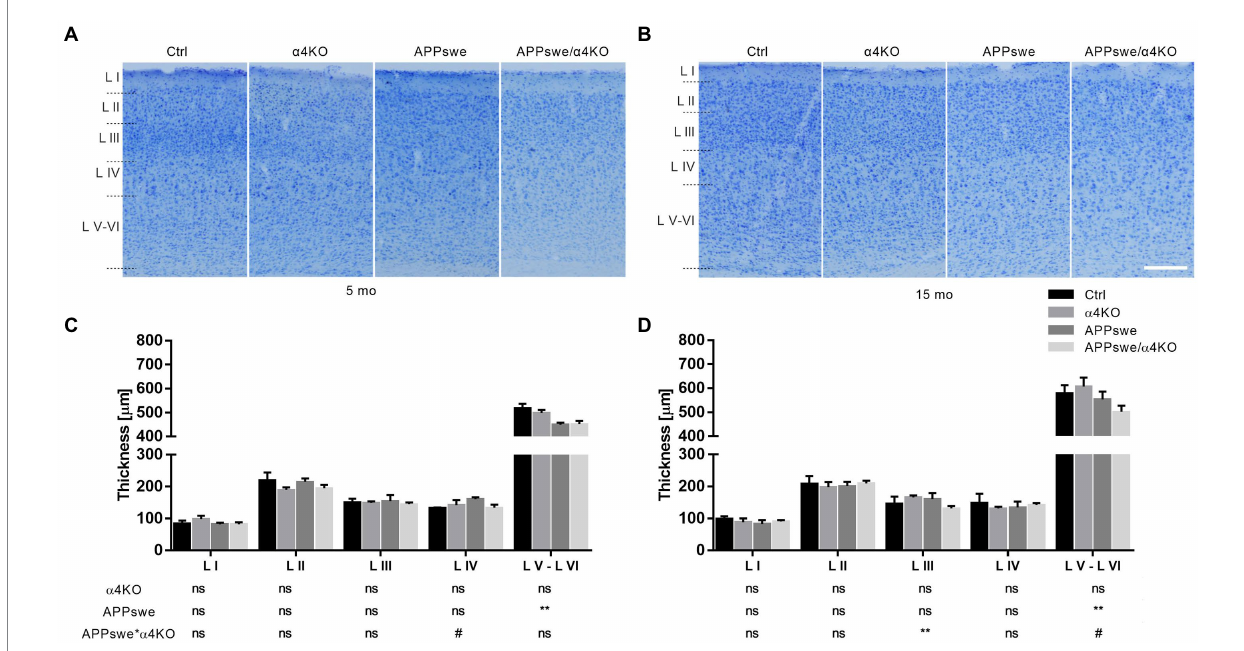
FIGURE 2 Quantitative analysis of Nissl-stained somatosensory cortex of 5 mo (A,C) and 15 mo (B,D) mice. Representative images of Nissl staining in layers I–VI of sCtx of 5 mo (A) and 15 mo (B) Ctrl, α 4KO, APPswe, and APPswe/ α 4KO mice and relative quantification (C,D) . Scale bar: 200 μ m. Data are shown as mean ± SEM and compared by two-way ANOVA test, ** p < 0.01, # 0.10 > p > 0.05 as trend for a significant difference. L I–VI, layers